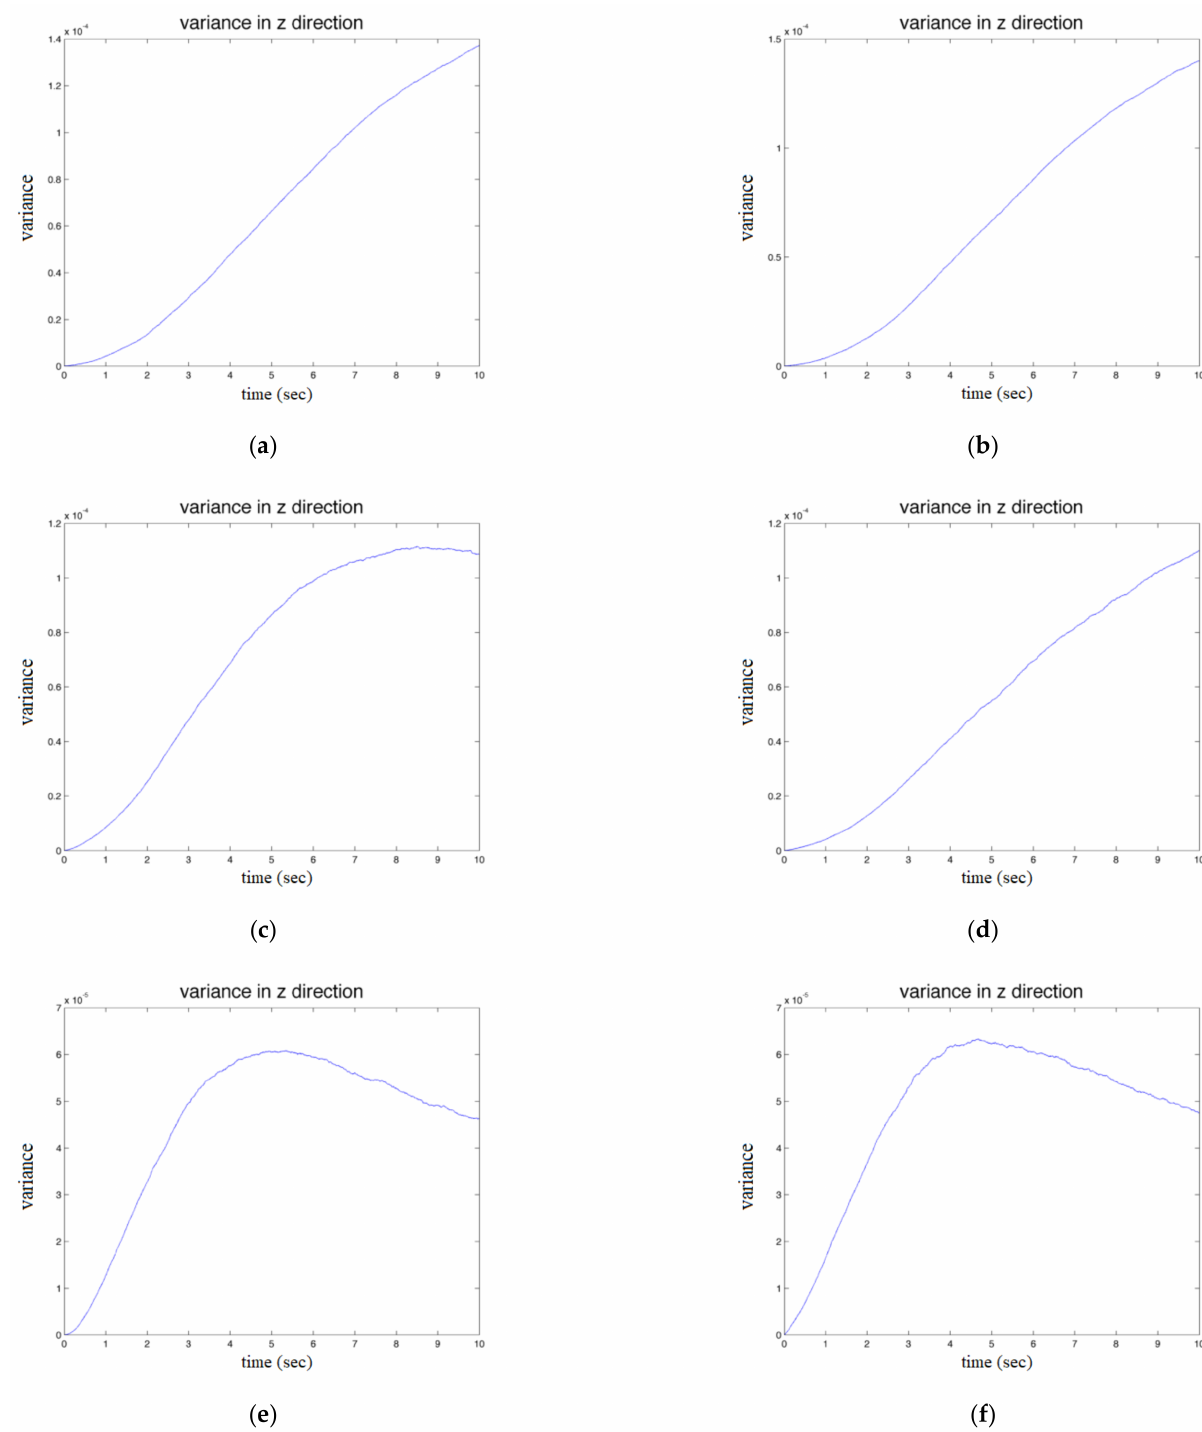
Figure 7. Final particle location variance in the z-direction: ( a ) final probable source location variance in backward tracking tests with the diffusivity of Rouse [37], using the explicit method; ( b ) final probable source location variance in backward tracking tests with the diffusivity of Rouse [37], using the implicit method; ( c ) final probable source location variance in backward tracking tests with the diffusivity of Absi et al. [38], using the explicit method; ( d ) final probable source location variance in backward tracking tests with the diffusivity of Absi et al. [38], using the implicit method; ( e ) final particle location variance in forward tracking tests with the diffusivity of Rouse [37], using the explicit method; ( f ) final particle location variance in forward tracking tests with the diffusivity of Absi et al. [38], using the explicit